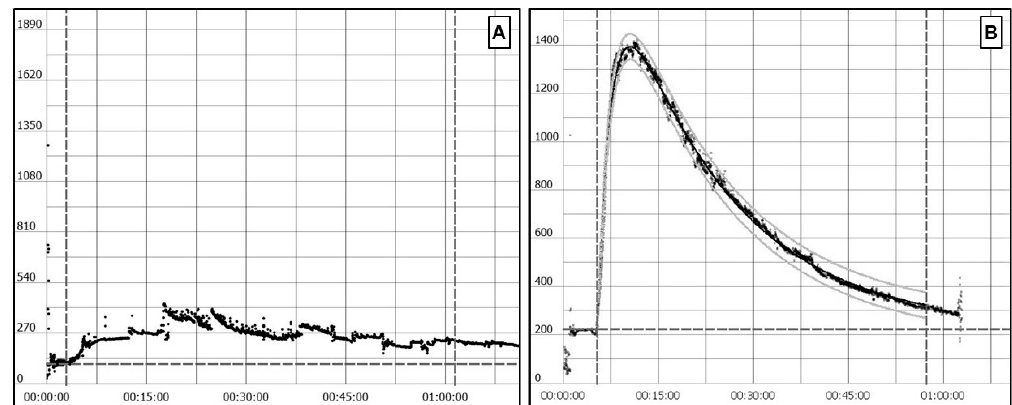
Figure 2. Transcutaneous measuring results fitted to a decay curve. ( A ), Wrong transcutaneous glomerular filtration rate (GFR) measurement. After skin background measurement there is no signal peak, as FITC-sinistrin was not correctly administered intravenously. ( B ) Correct transcutaneous GFR measurement. The curve shows a basal measurement of the skin background followed by a signal peak after FITC-sinistrin intravenous bolus administration.